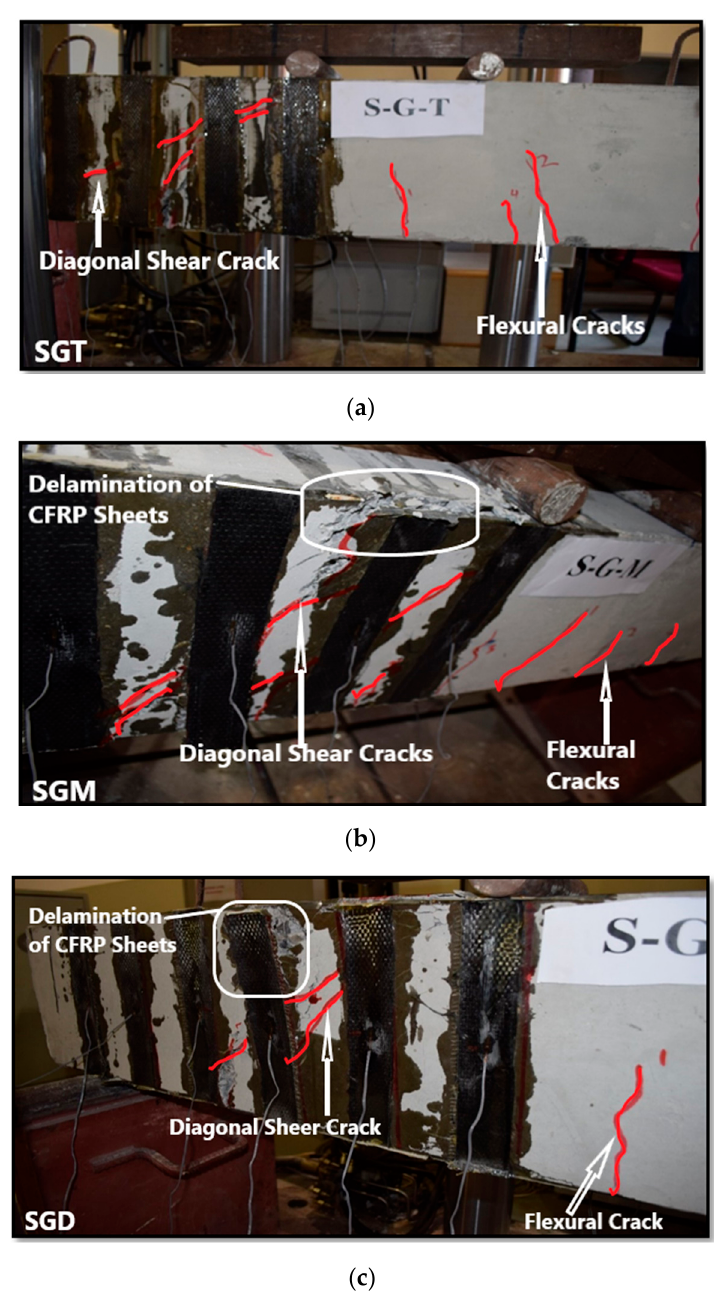
Figure 10. Failure modes: ( a ) SGT beam; ( b ) SGM beam; ( c ) SGD beam.